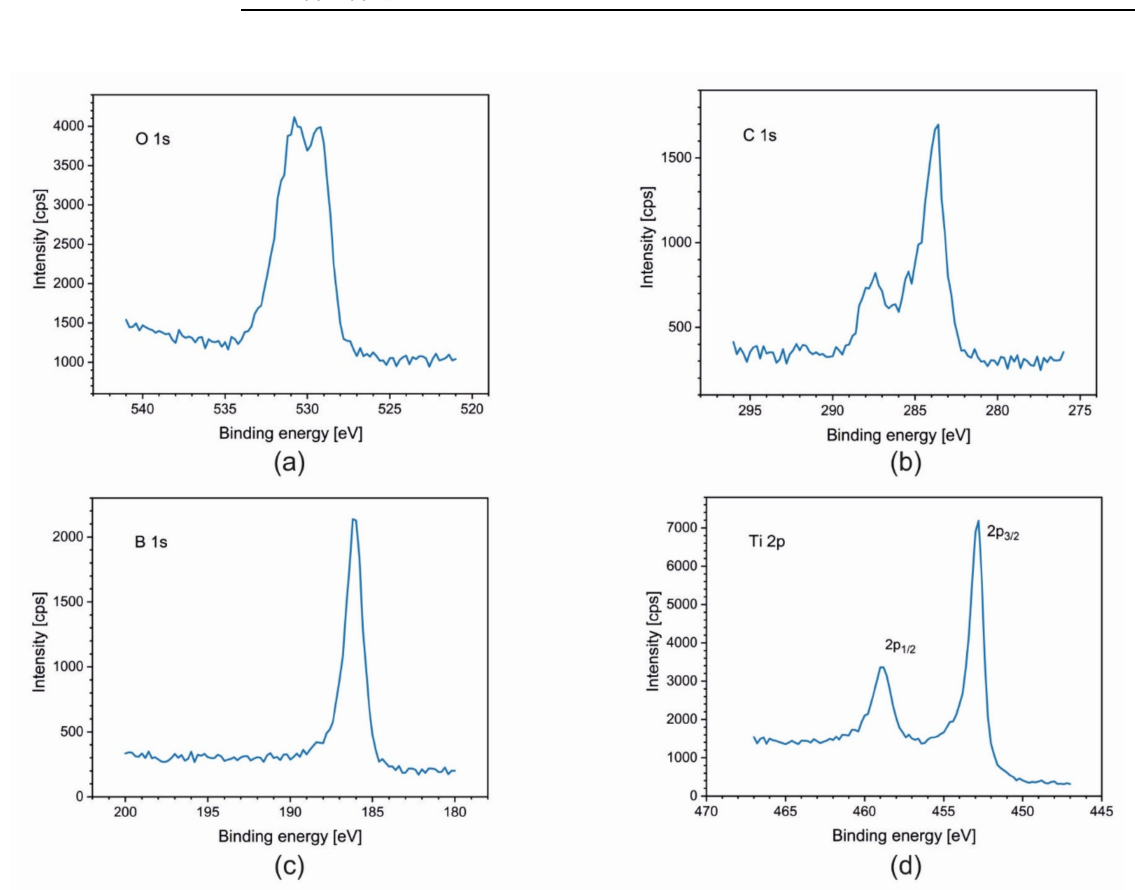
Figure 5. XPS spectra of ( a ) O1s; ( b ) C1s from the surface; ( c ) B 1s; and ( d ) Ti 2p obtained after 140 min of sputtering for the coating TiB 2 .